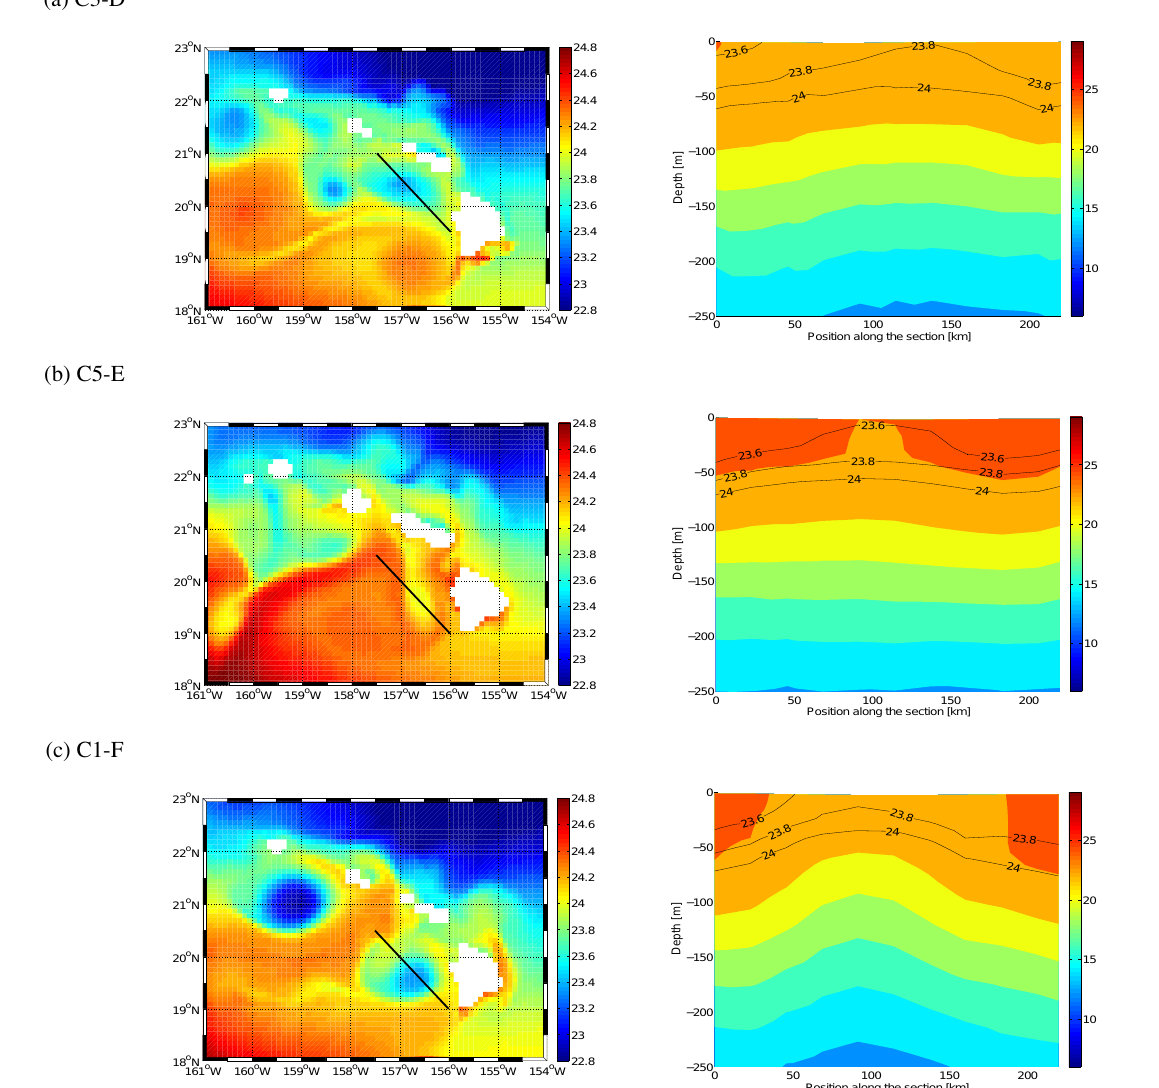
Fig. 10. Left: surface temperature maps with position of the transects (black straight line) crossing the center of a cyclonic eddy on April 13 for Run-E (middle) and on 28 March for both Run-D (top) and Run-F (bottom). Right: corresponding vertical sections of temperature. The black lines in the vertical sections represent σ t eddies is too low (0.23–0.24 m s − 1 ). Both simulations